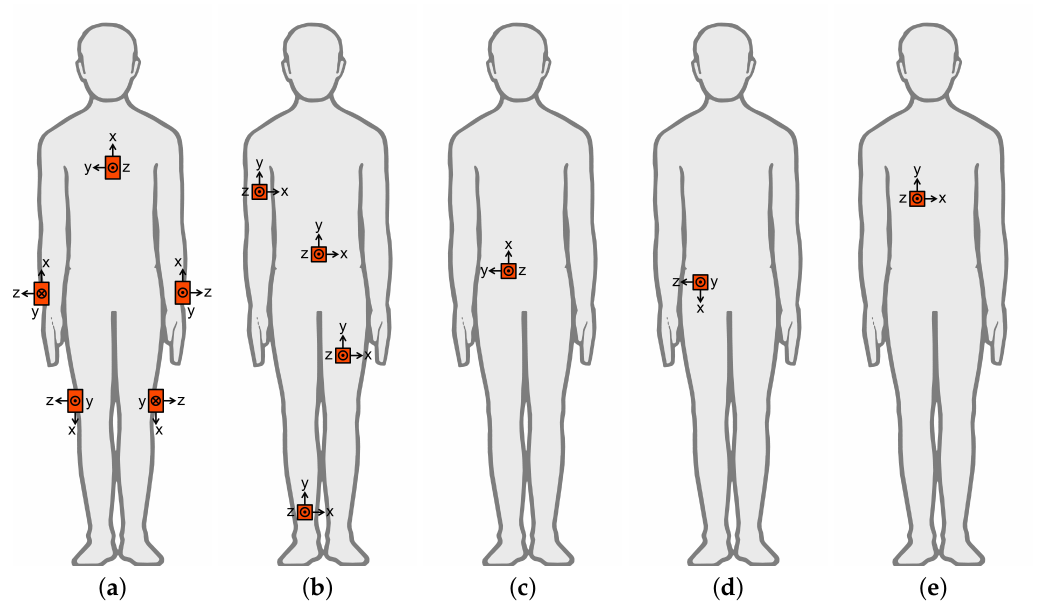
Figure 4. ( a – e ) Sensor configurations in datasets A–E. The body drawing in the figure is from http: //www.clker.com/clipart-male-figure-outline.html onto which sensor units were added by the